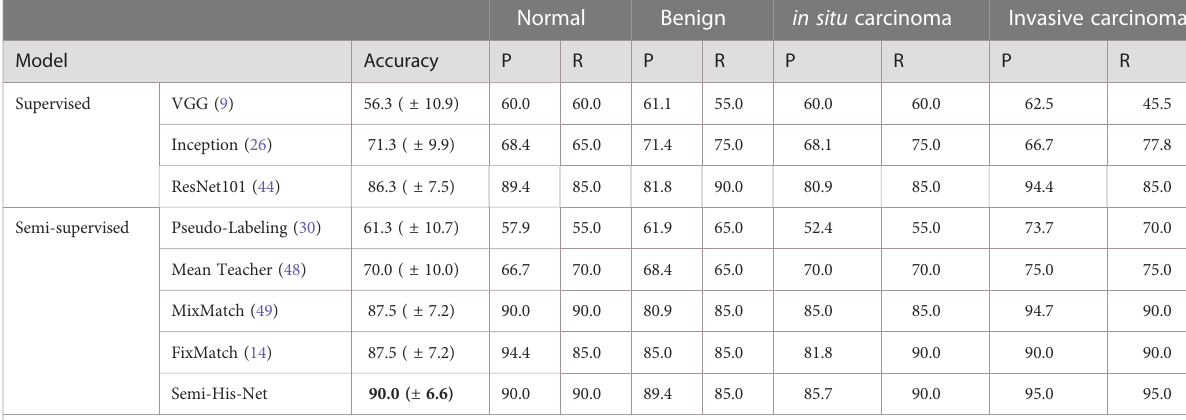
TABLE 2 Comparison of different classi fi cation